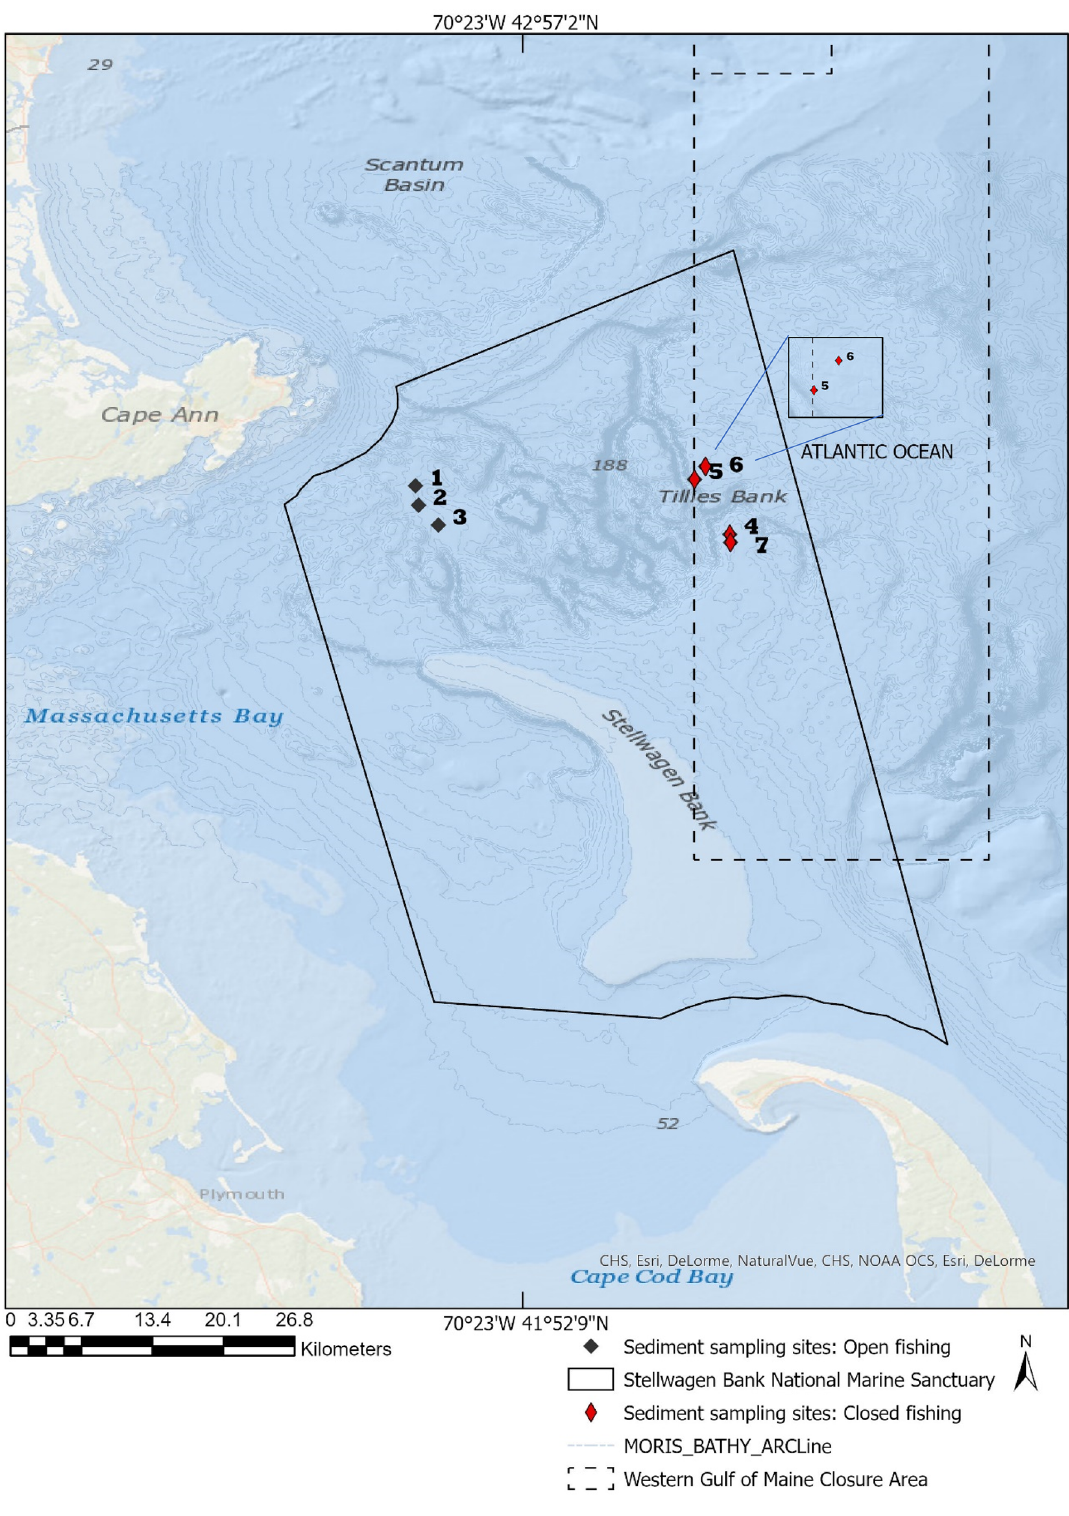
Figure 1. Map of sampling sites. Black symbols indicate open to fishing. Red symbols indicate closed to fishing, 30 m within the closure boundary. Note: Map was created by the authors using ArcGIS Pro 2.8 based from the NOAA Coastal Survey Data (https:// www. nauti calch arts. noaa. gov/ data/ gis- data- and- servi ces.